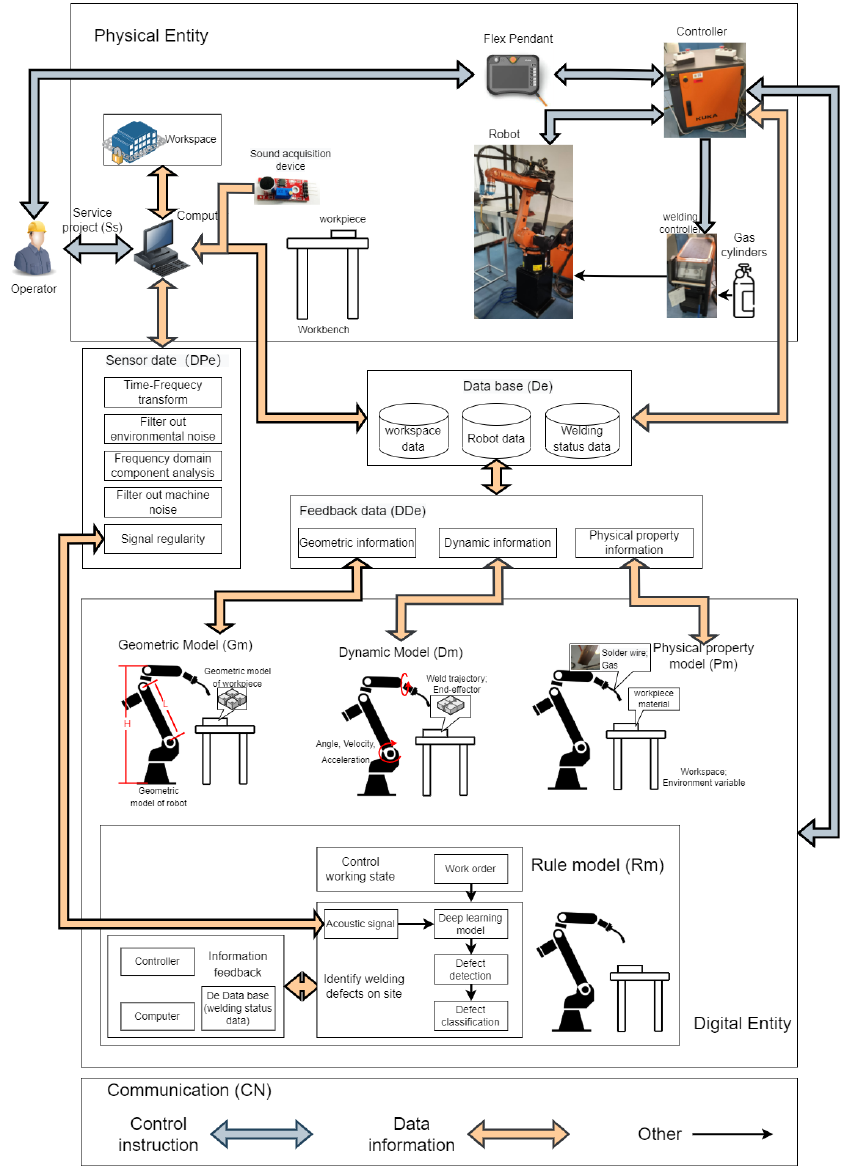
Figure 1. Digital twin